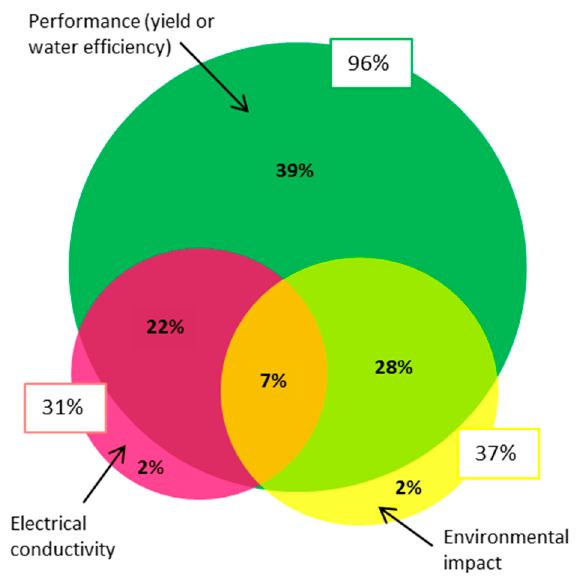
Figure 2. Distribution of studies based on the study environment ( left ) and experimental crop ( right ).